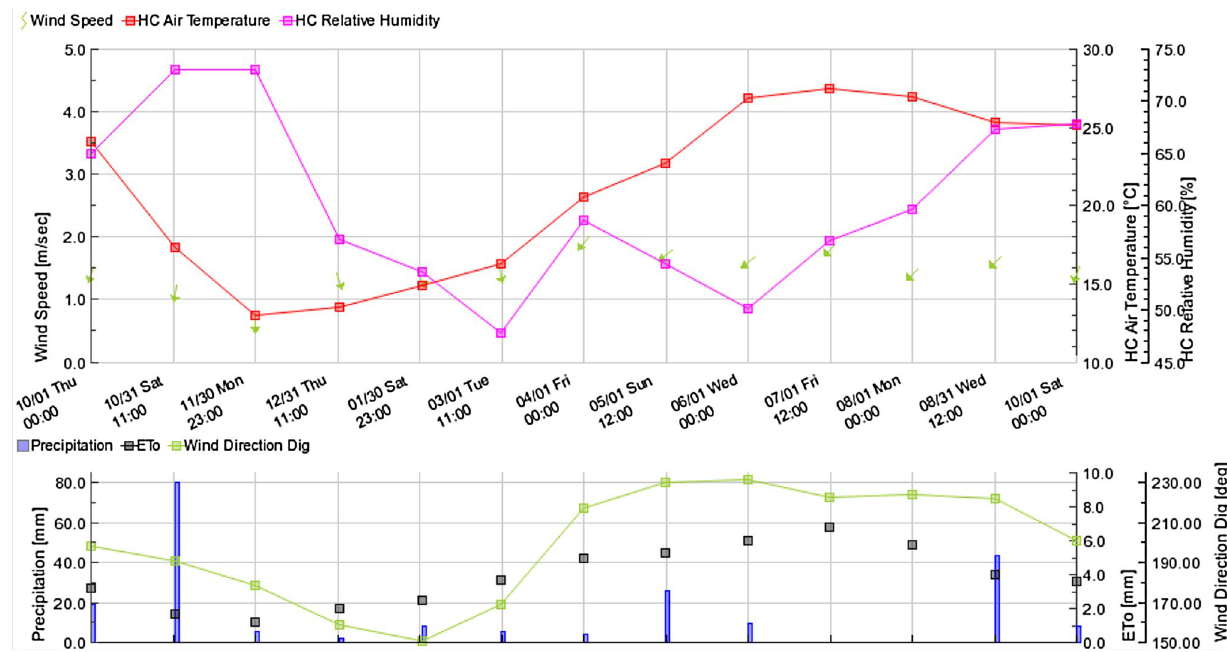
Fig. 1 The meteorological factors of study Zone; Month temperature (°C) Evaporation (mm per days); Relative humidity (%), Wind speed (m per second) and Dominant wind